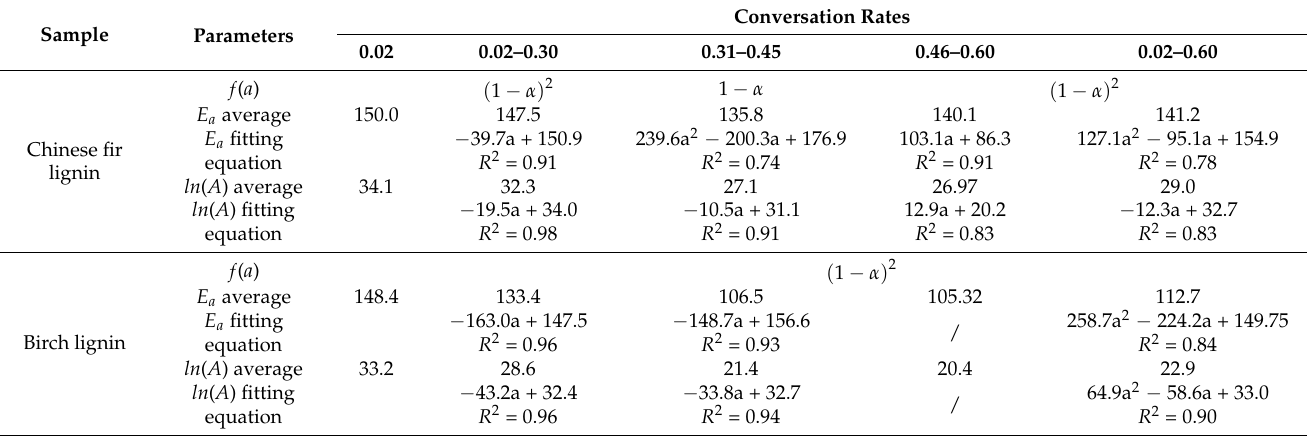
Figure 8. Activation energy and natural logarithm pre-exponential factor of ( a ) Chinese fir DEL and ( b ) birch DEL. (The left arrow indicates the Y axis of the curve is on the left side, and the right arrow indicates the Y axis of the curve is on the right side.) Table 2. Kinetic parameters of thermal degradation of fir DEL and birch DEL at different conversion rates.